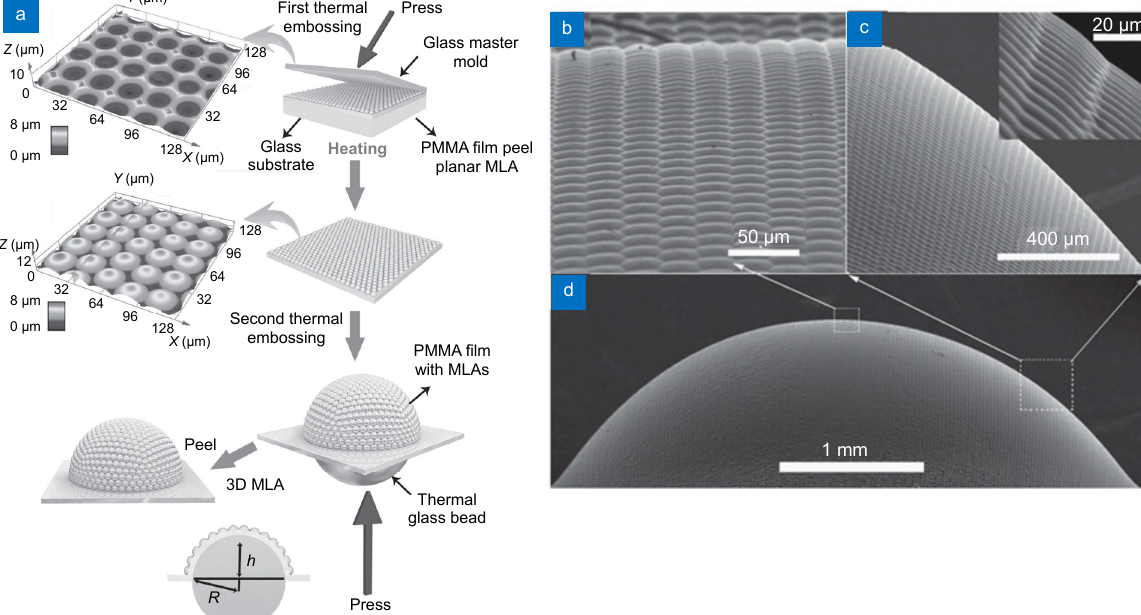
Fig. 7 | Fabrication of 3D polymer compound eyes. ( a ) Diagram of fabrication of polymer compound eyes by replication of microlens arrays mask fabricated by femtosecond laser modification with subsequent wet etching. ( b–d ) SEM images of the polymer compound eye. Figure reproduced from (a–d) ref. 95 , WILEY-VCH Verlag GmbH & Co. KGaA,